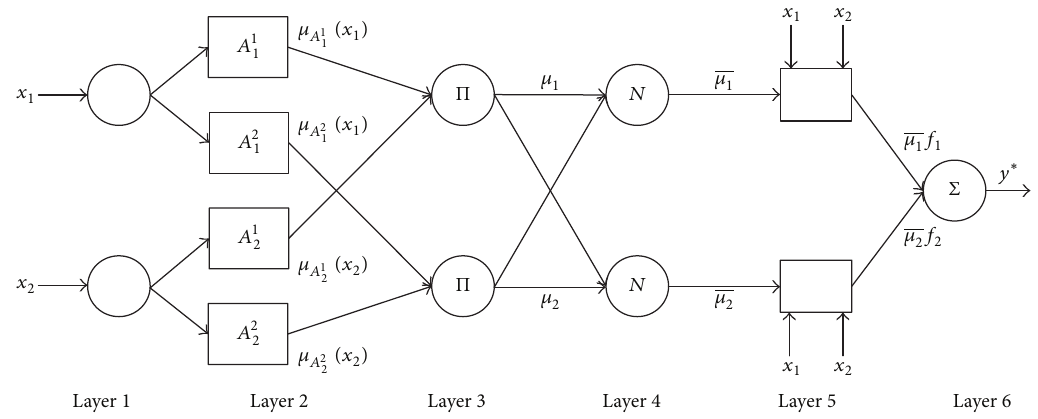
Figure 5: ANFIS model architecture.